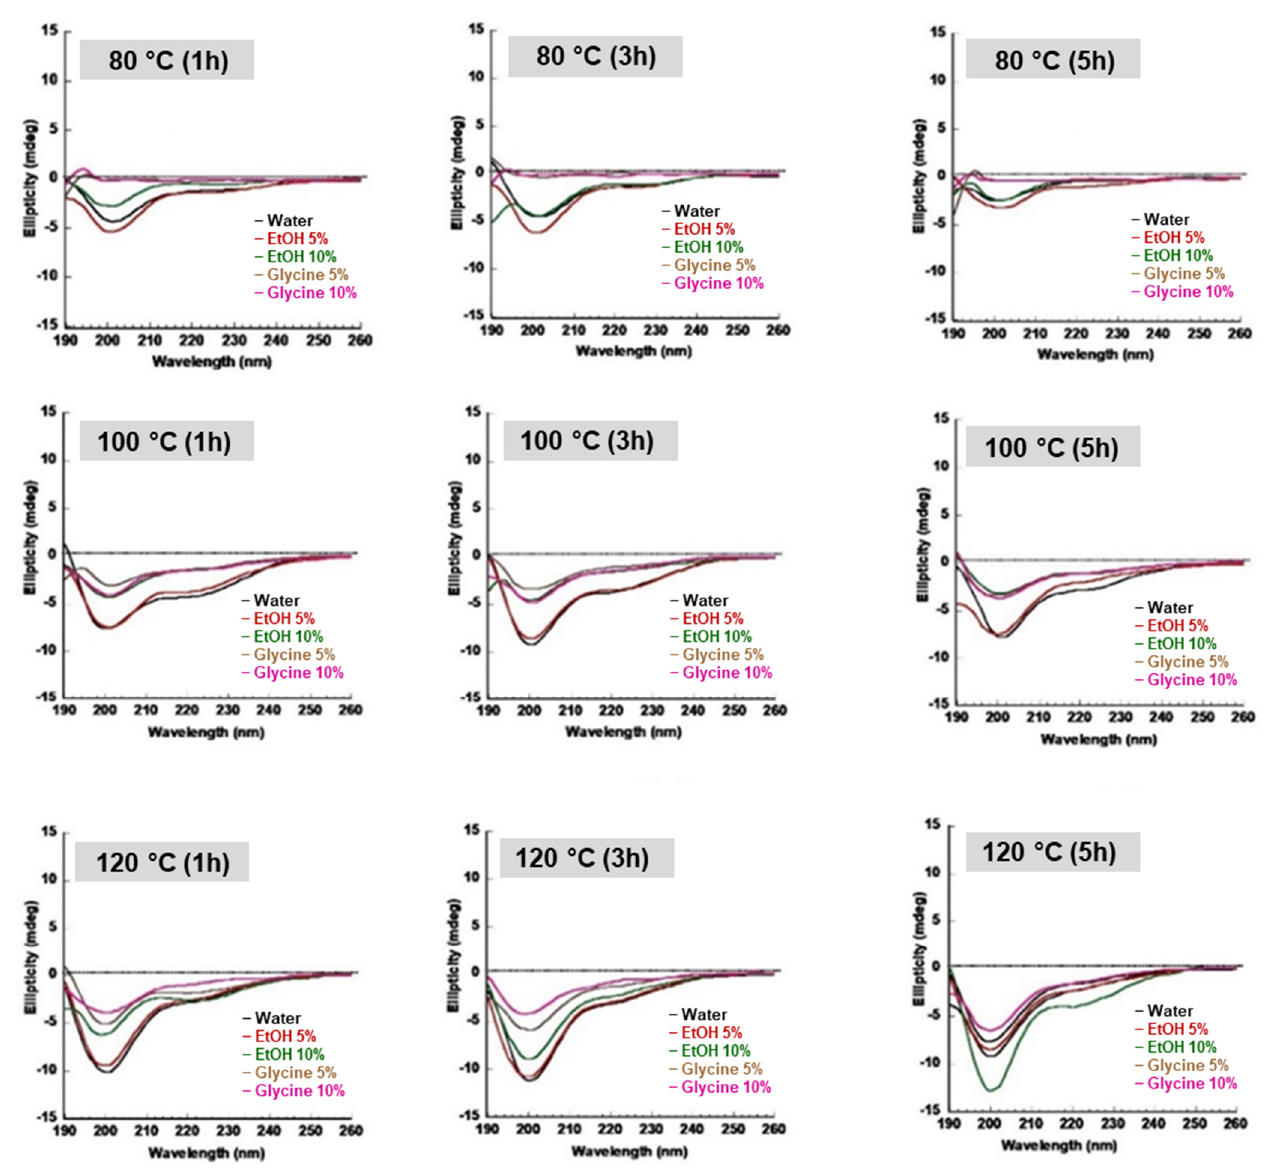
Figure 4. CD spectrum of SS solution. The secondary structure of SS was investigated according to extracted temperature (80 ◦ C, 100 ◦ C, and 120 ◦ C) and time (1, 3, and 5 h). The SS structural transition in days Figure 6 was studied at 4 ◦ C, which is the general storage condition for SS; the structural change was observed to intensify in all the samples over time from random coil to the β -sheet structures. The transformation of the random coil peak at 198 to 200 nm was observed to decrease, while the β -sheet peak around 218–220 nm was observed to increase. Interestingly, Figure 6C shows that the glycine extract transition was slower compared to water Figure 6A and EtOH 5% Figure 6B